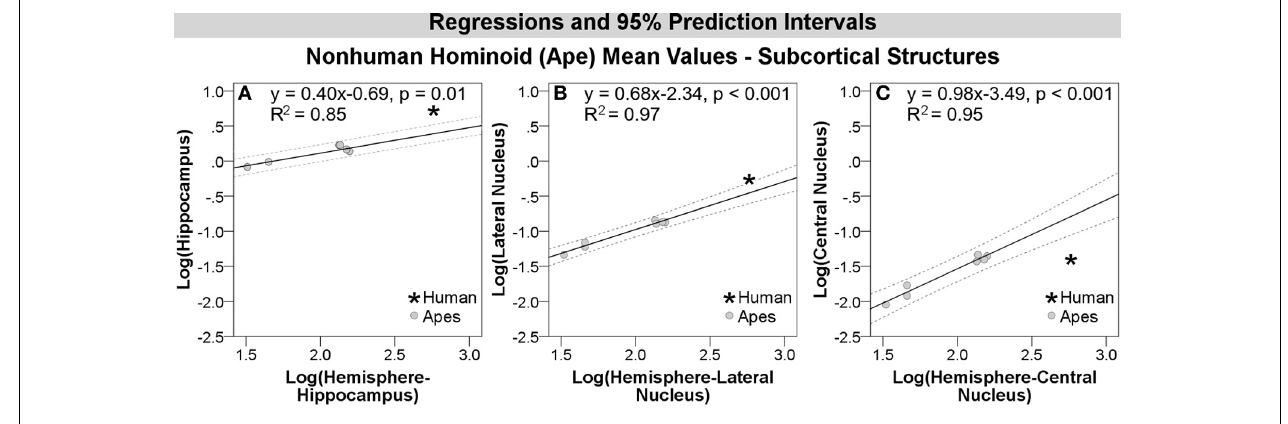
FIGURE 5 | Log-log regressions and 95% prediction intervals (dashed lines) of species average volumes (cc) for select subcortical structures in the hominoid dataset, which reached